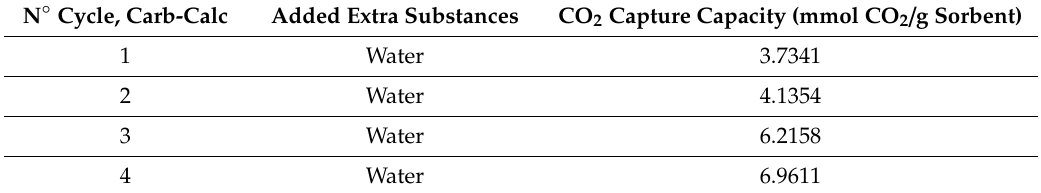
Table4. CO 2 capturecapacityforseveralcyclesofcarbonation–calcinationusingthemechanochemicalprocess. N ◦ Cycle,